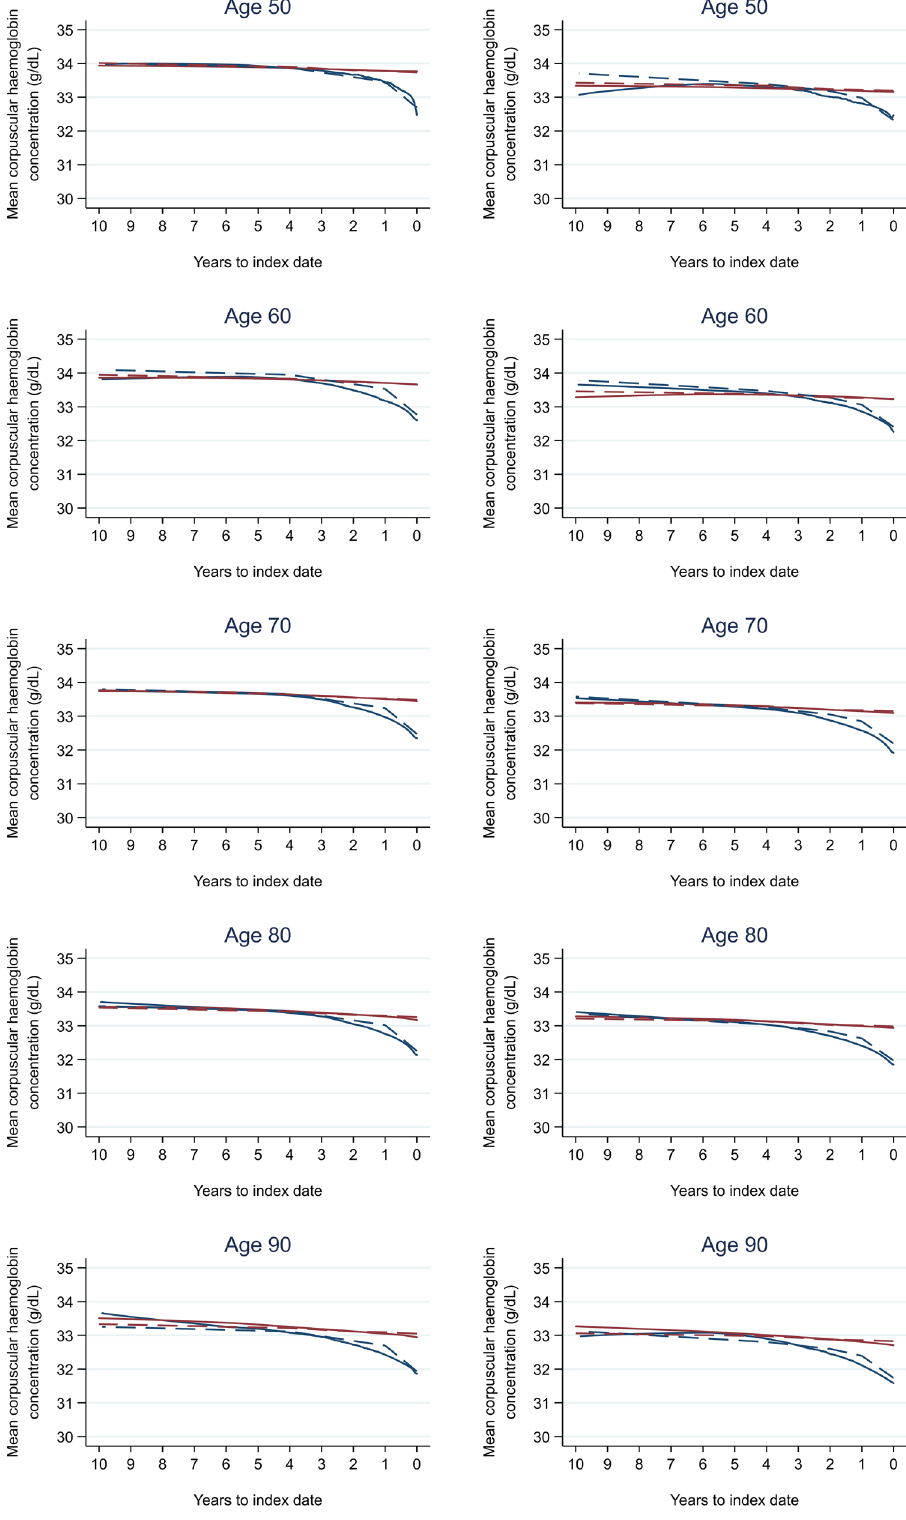
Figure 9. Mean corpuscular haemoglobin concentration trends between cases and controls, by age at index date 1,2 . 1 Index date was the date of diagnosis for cases and a randomly selected date in the patient’s study period for controls. 2 LOWESS trends are age (+/- 3 years) and modelled (fixed effects) trends are taken at that specific age. Legend: males (left) and females (right). Colorectal cancer (blue line) and no cancer (red line). LOWESS trend (solid line) and modelled trend (dashed line).